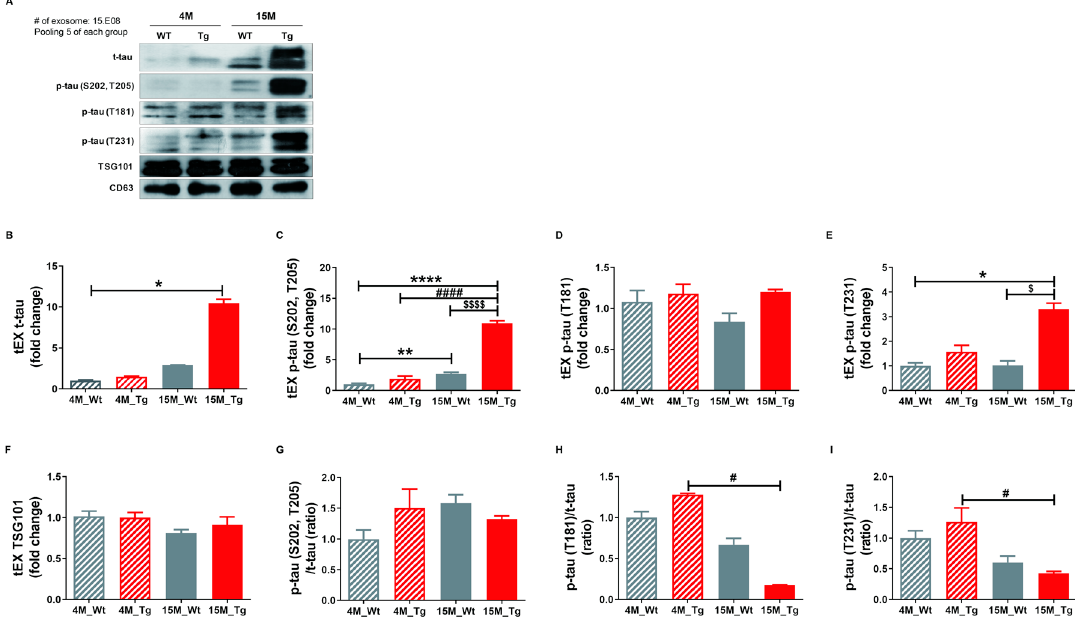
Figure 5. Total tau and phosphorylated tau expression levels in brain tissue exosomes of JNPL3 mice increase with the progression of pathology. Total tau and phosphorylated tau protein expression in brain tissue exosomes (tEX) were validated by Western blot. ( A ) Representative Western blot. Relative expression levels of ( B ) t-tau, ( C ) hyperphosphorylated tau (p-tau (S202, T205)), ( D ) p-tau (T181), ( E ) p-tau (T231), and ( F ) TSG101 as well as the ( G ) p-tau (S202, T205) / t-tau ratio, ( H ) p-tau (T181) / t-tau ratio, and ( I ) p-tau (T231) / t-tau ratio in tEX. tEX t-tau was higher in 15-month-old JNPL3 mice (15M-Tg) than